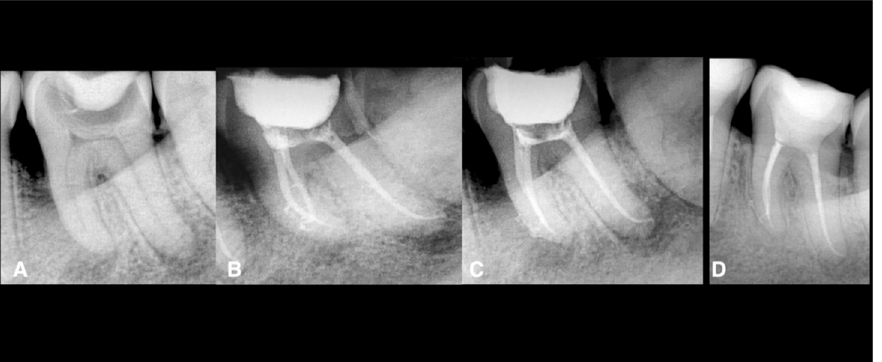
Figure 1. Endodontic treatment of a second mandibular left molar. The tooth was necrotically associated with periapical lesions. The treatment was done using conservative shaping and the 3D cleaning procedure, as mentioned in the Materials and Methods. ( A ) Preoperative X-ray, ( B ) postoperative X-ray, ( C ) postoperative X-ray with different angulation, ( D ) 2-year follow-up showing healing.